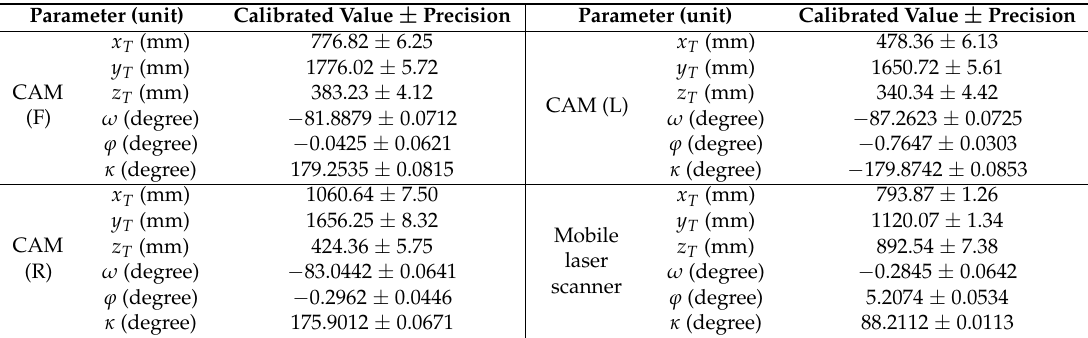
Table 6. Boresight and lever-arm calibration results (precision: 1 σ ).